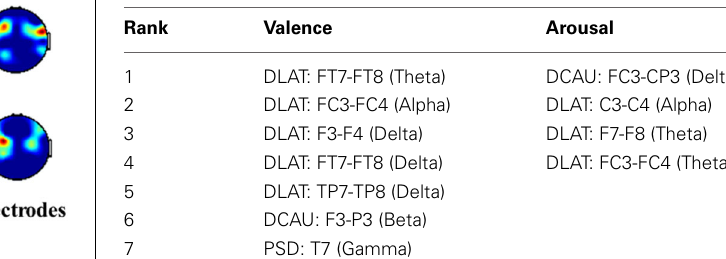
FIGURE 6 | The topographic mapping of informative EEG features consistently appeared in multiple subjects. The rightmost topography color-codes the importance of electrodes according to how frequent the electrodes were used to derive the corresponding